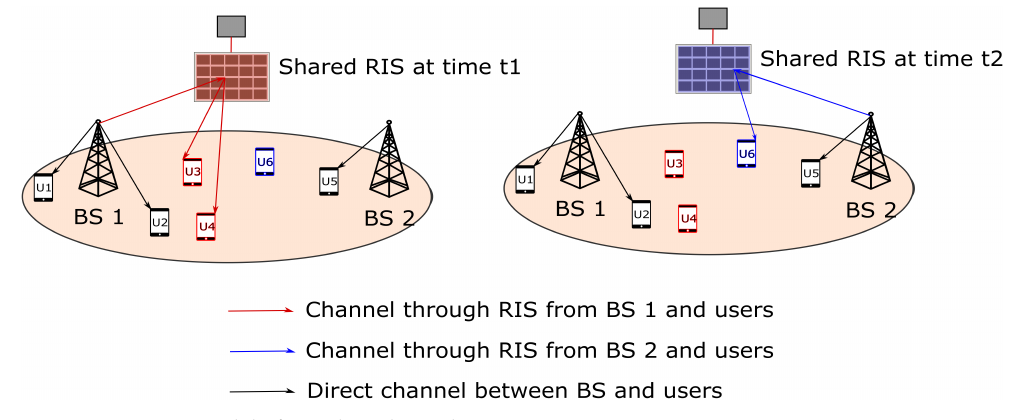
Figure 2. System model of time based RIS